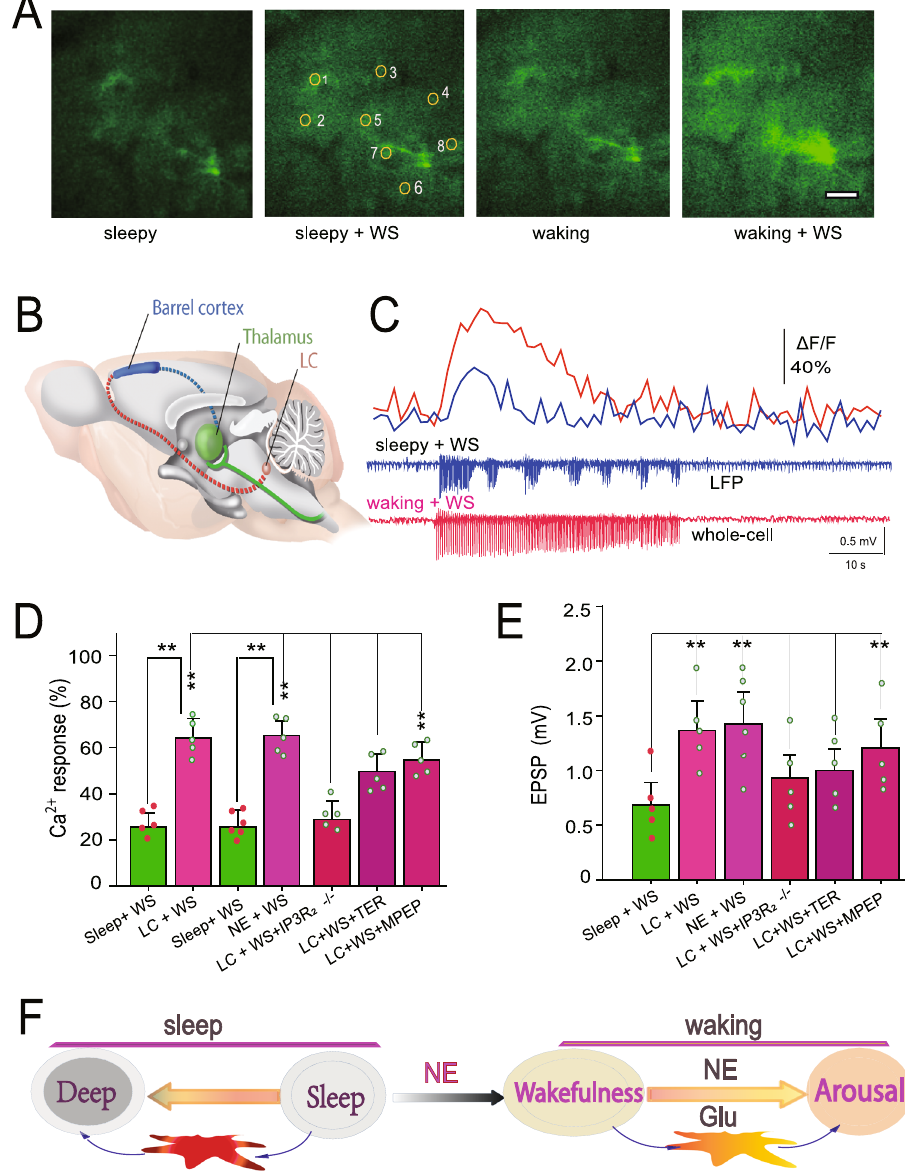
large waves. A Typical fl uorescent images show that LC stimulation can induce largeCa 2+ increasesafterLCstimulation.Scalebar=20 µ m. B Aschematicillustrates projections from LC stimulation (red dashed line) and whisker stimulation (green solid line and blue dashed line) to the barrel cortex. LC stimulation was generated using bipolar concentric electrodes, while whisker stimulation was generated through air puf fi ng. C Typical traces show the changes in Ca 2+ transients and